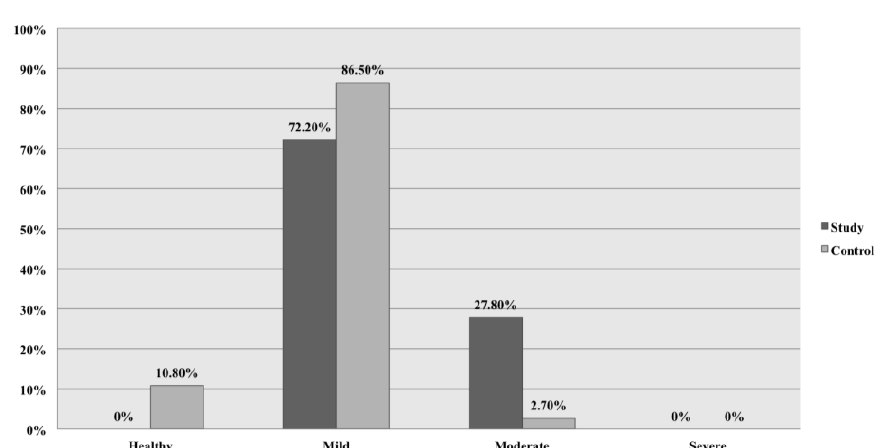
Figure 1: The gingival inflammation severity among study and control